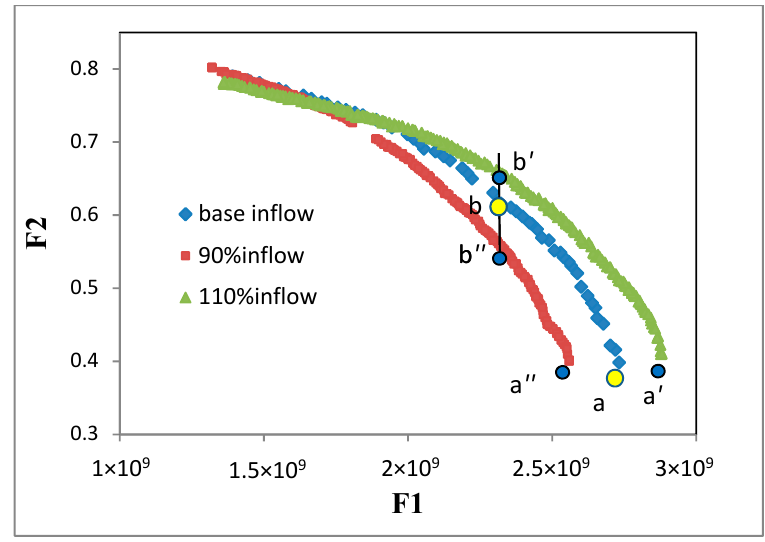
Figure 12. Sensitivity of the Pareto front to a decrease and increase of 10% in the inflow of water into the study area. Table 6. Sensitivity Analyses, Various Parameters.